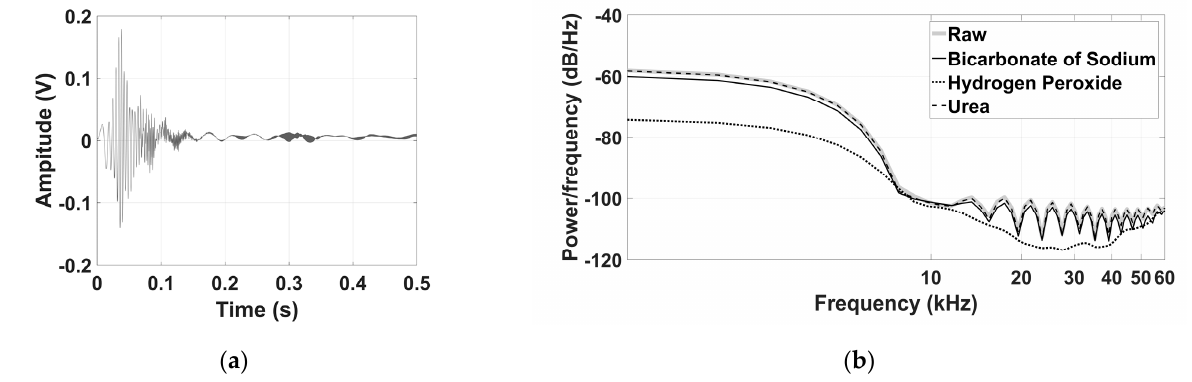
Figure 4. Received signal from non-contaminated milk ( a ). Spectral power density for contaminated and non-contaminated milk ( b ).